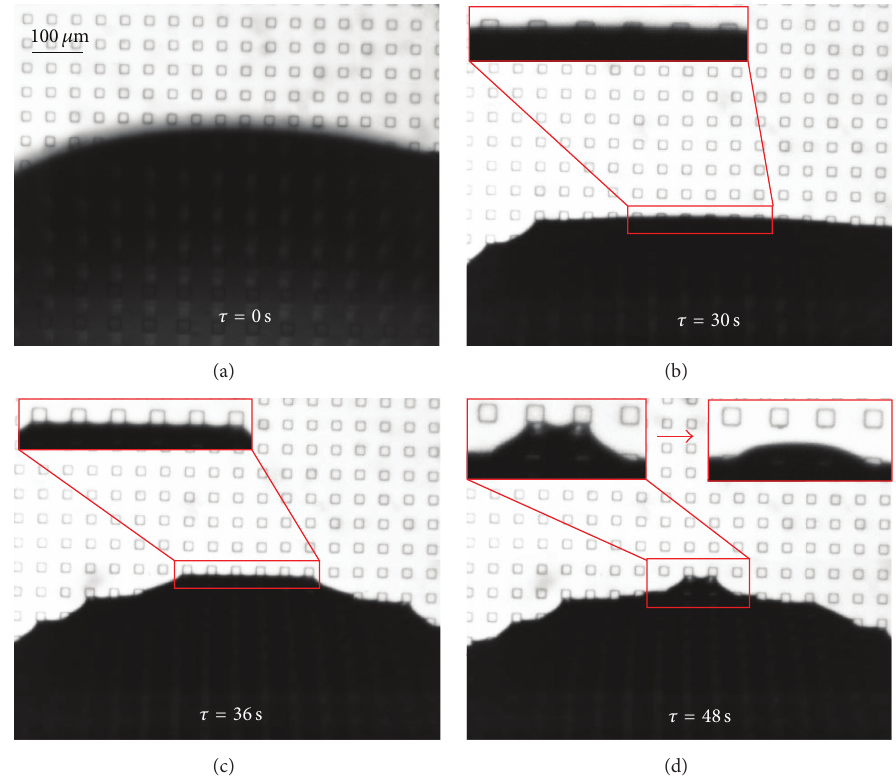
Figure 2: Contact line of a Wenzel state droplet on micropillared